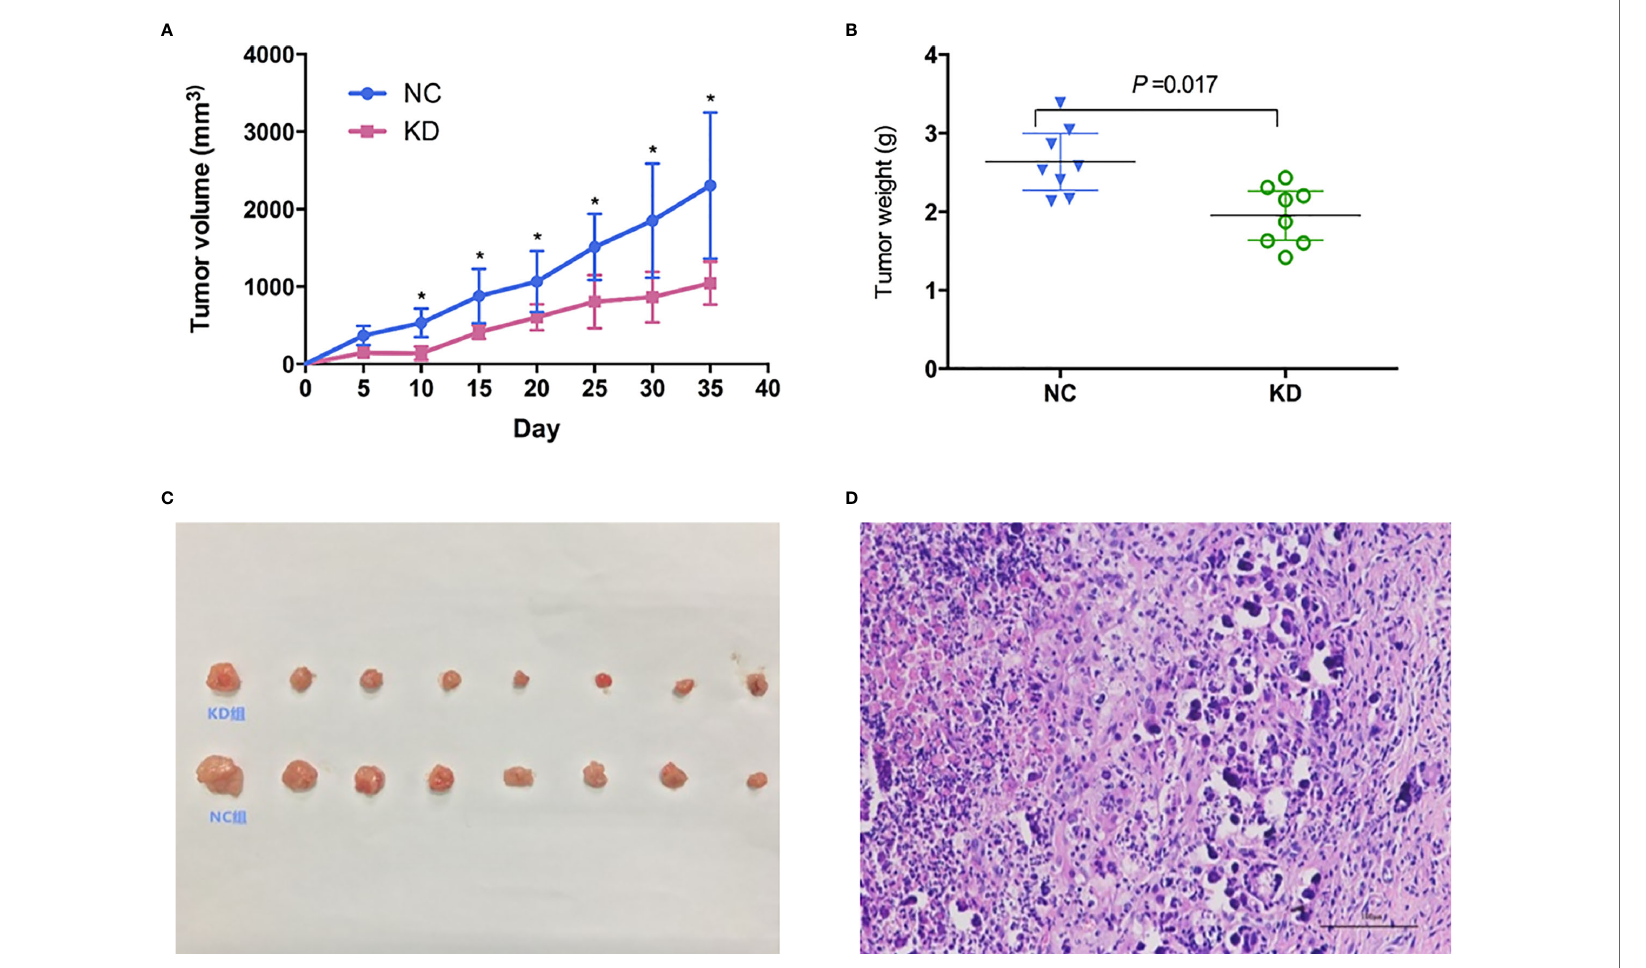
FIGURE 3 | Effects of CX3CL1 knockdown on (A) tumor volume and (B) weight changes in a nude mouse subcutaneous tumor model of bladder cancer. The results showed that compared with the control group, the volume and weight of subcutaneous tumors in the KD group decreased signi fi cantly. (C) Subcutaneous tumor in KD (up) and NC (down) group. (D) Hematoxylin & Eosin staining of the tumor cells. KD, knockdown; NC, negative